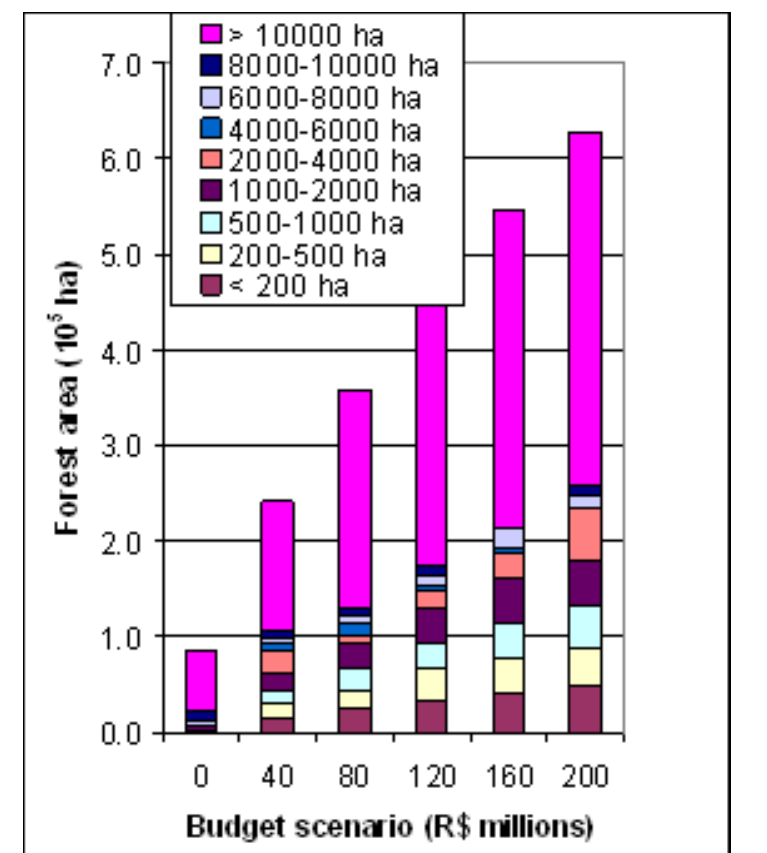
Fig. 3. Extent of conserved forest fragments by fragment size class and budget